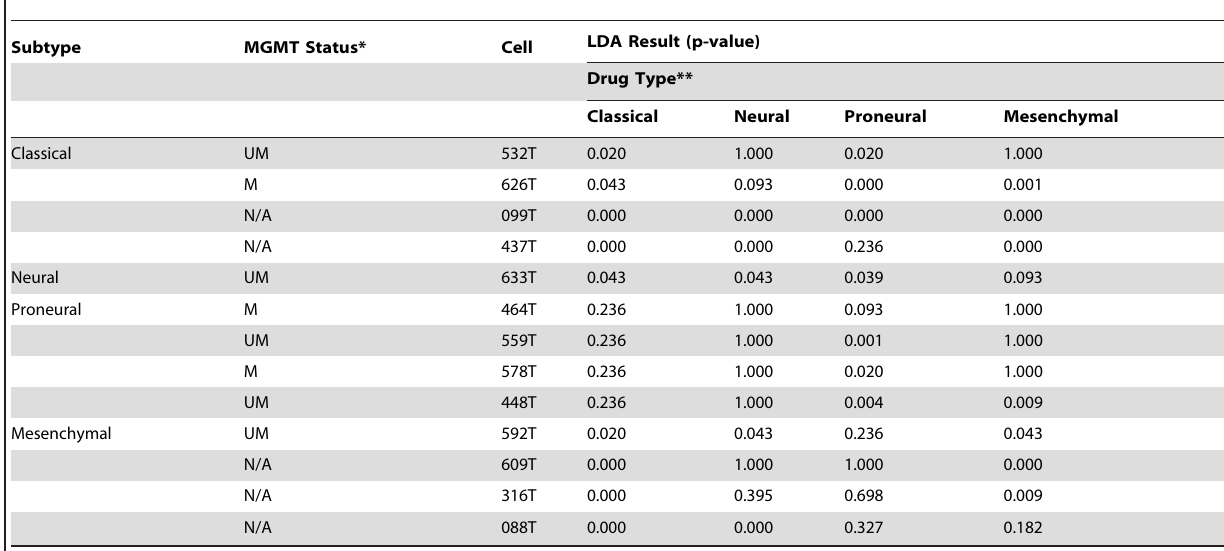
Table 1. Single treatment effects of molecular subtype specific drugs on patient-derived GBM cells.